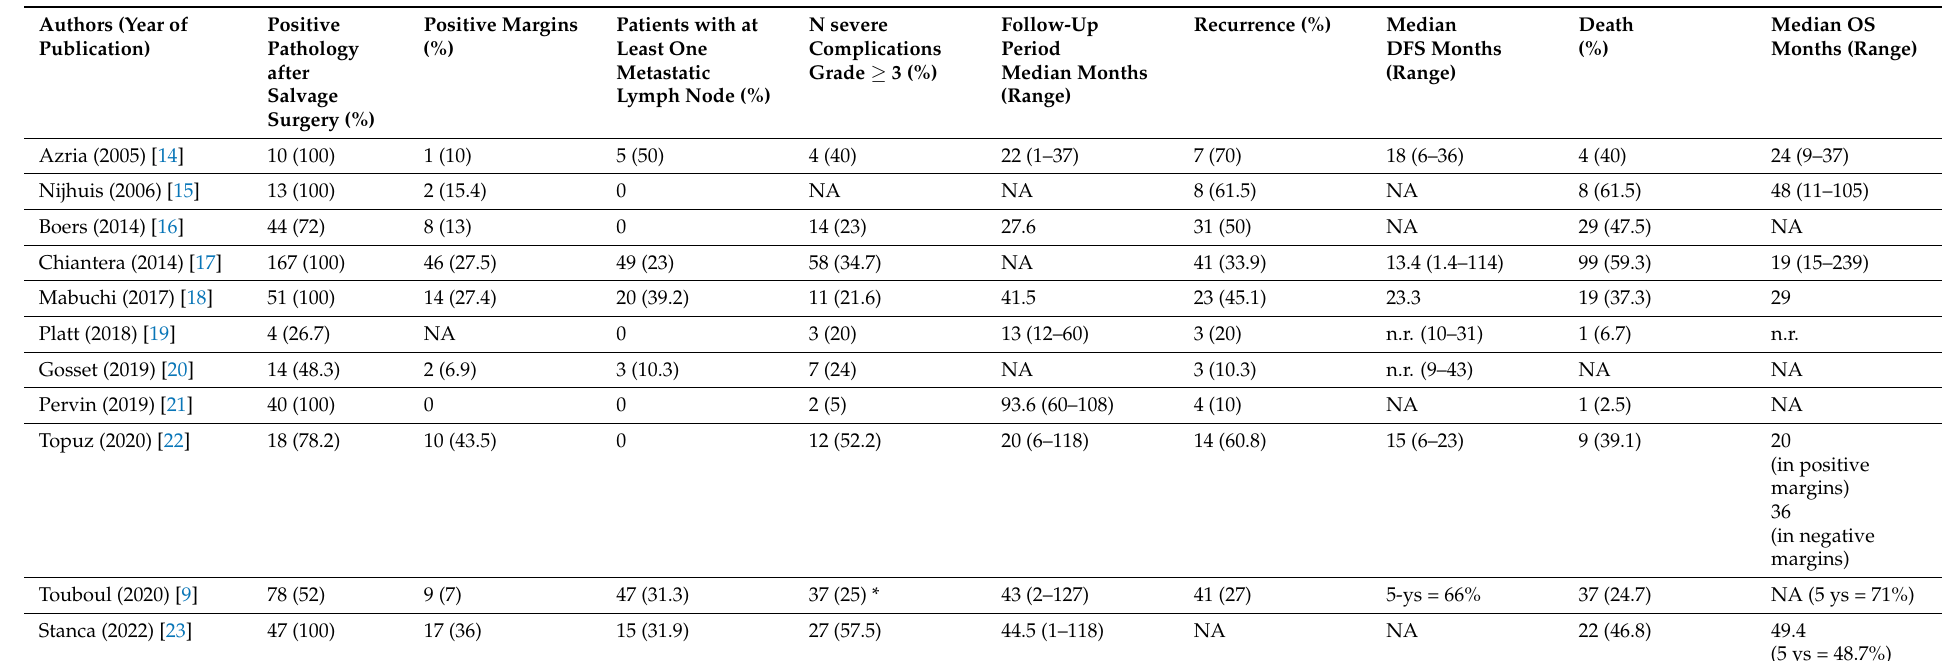
Table 3. Outcomes of studies included in the analysis